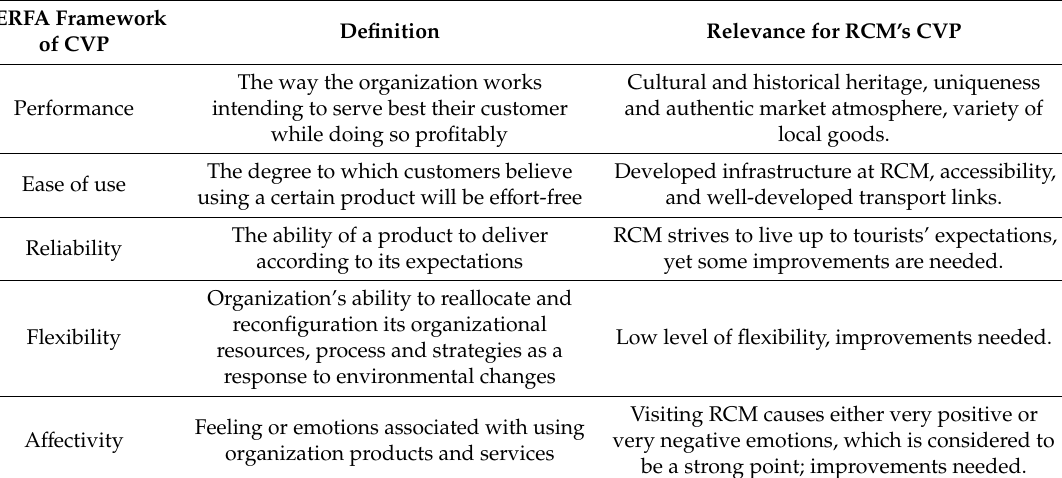
Table 2. The PERFA framework for CVP applied to